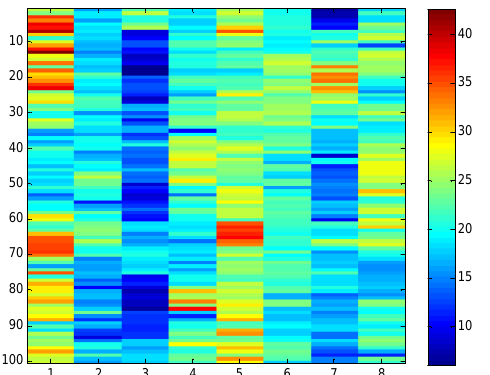
Figure 15. Dissimilarity parameter derived from co-occurrence matrix for each sample (1: agricultural, 2: airplane, 3: beach, 4: buildings, 5: chaparral, 6: dense residential, 7: forest, 8: harbor).